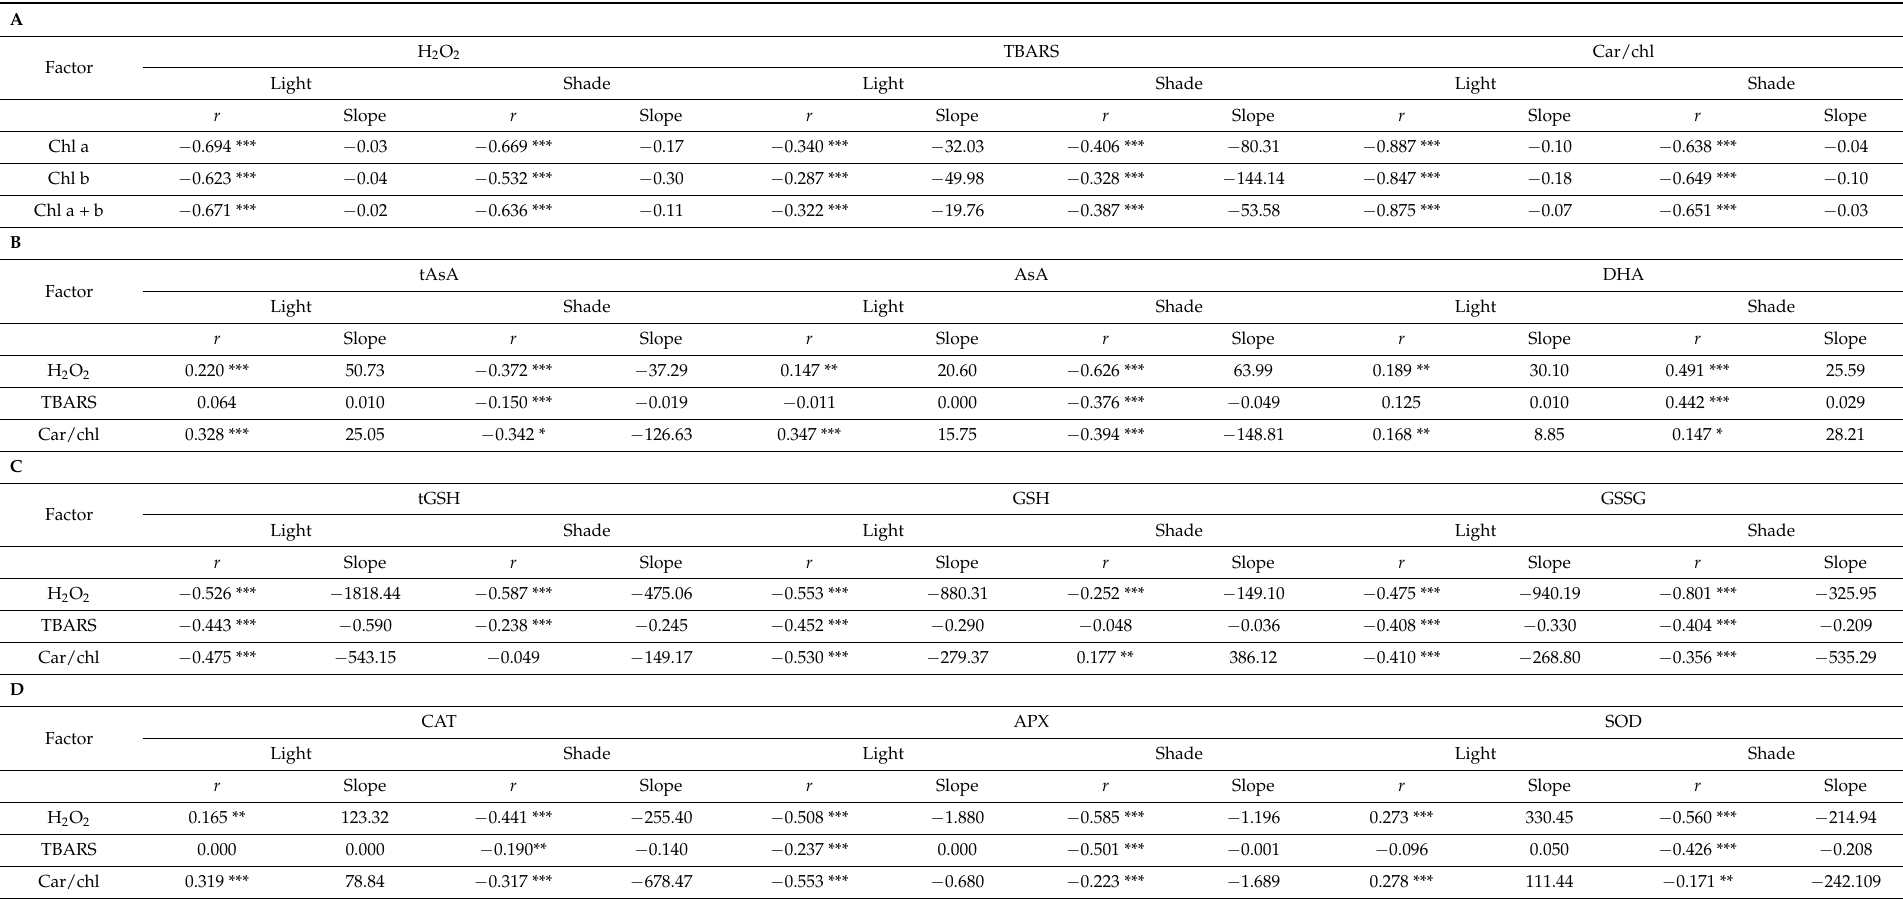
Table 3. Pearson’s correlation coefficients ( r ) and corresponding curve slope coefficients between chlorophylls (Chl a, Chl b, and Chl a + b) and oxidative stress markers (H 2 O 2 content, TBARS content, and car/chl) (A) and between oxidative stress markers and antioxidative parameters (tAsA, AsA, DHA, tGSH, GSH, and GSSG contents, and CAT, APX, and SOD activity) (B–D) of the sun and shade beech